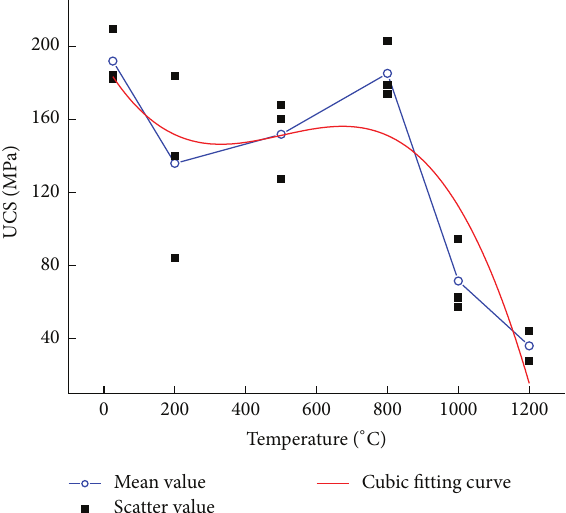
Figure 3: The whole stress-strain curves of rock samples after differ- ent temperature.